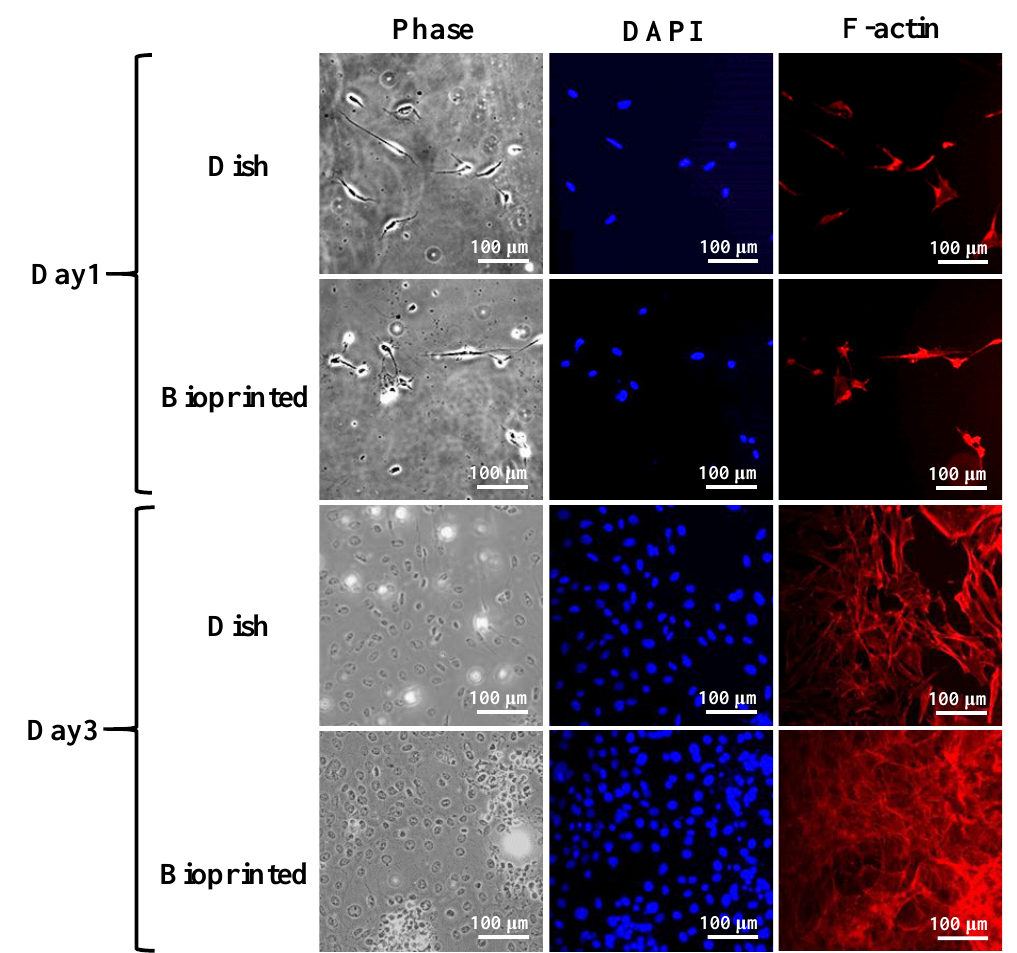
Figure 7. Cell proliferation of L929 fibroblasts in the 3BE-3 ( Φ 0.13 mm needle head) at days one and three after bioprinting. More cell proliferation was seen in day three compared to day one.